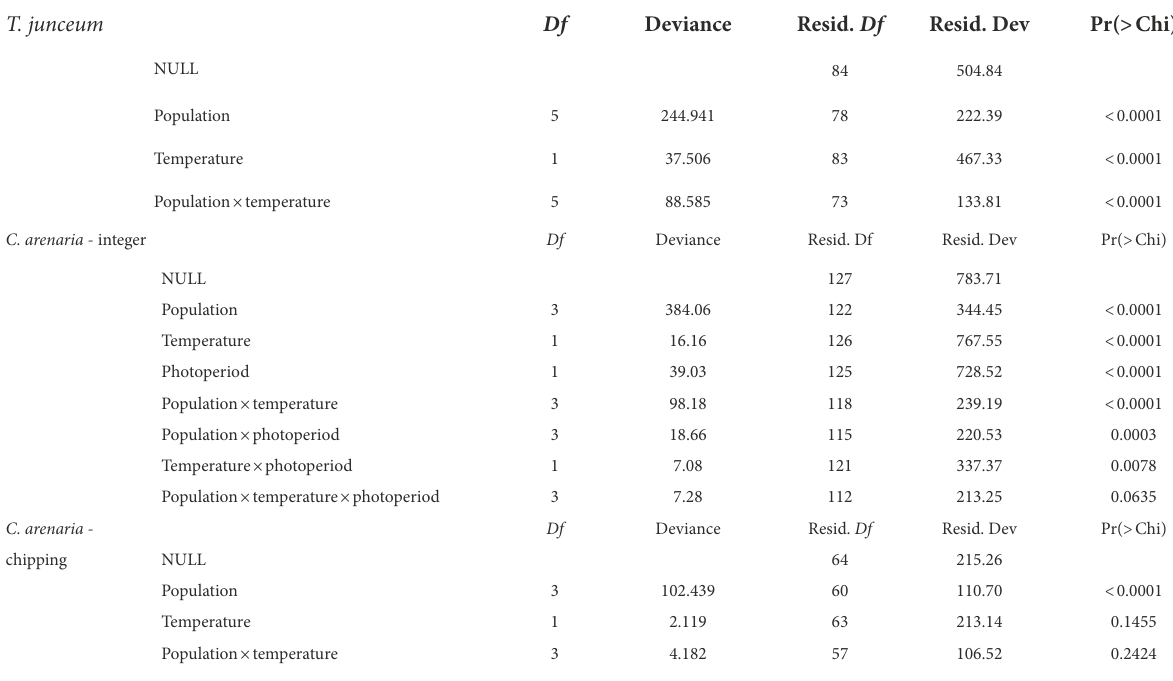
TABLE 2 Summary table of the GLMs to test the effect of temperature and the source population on seed germination of the target species. T.